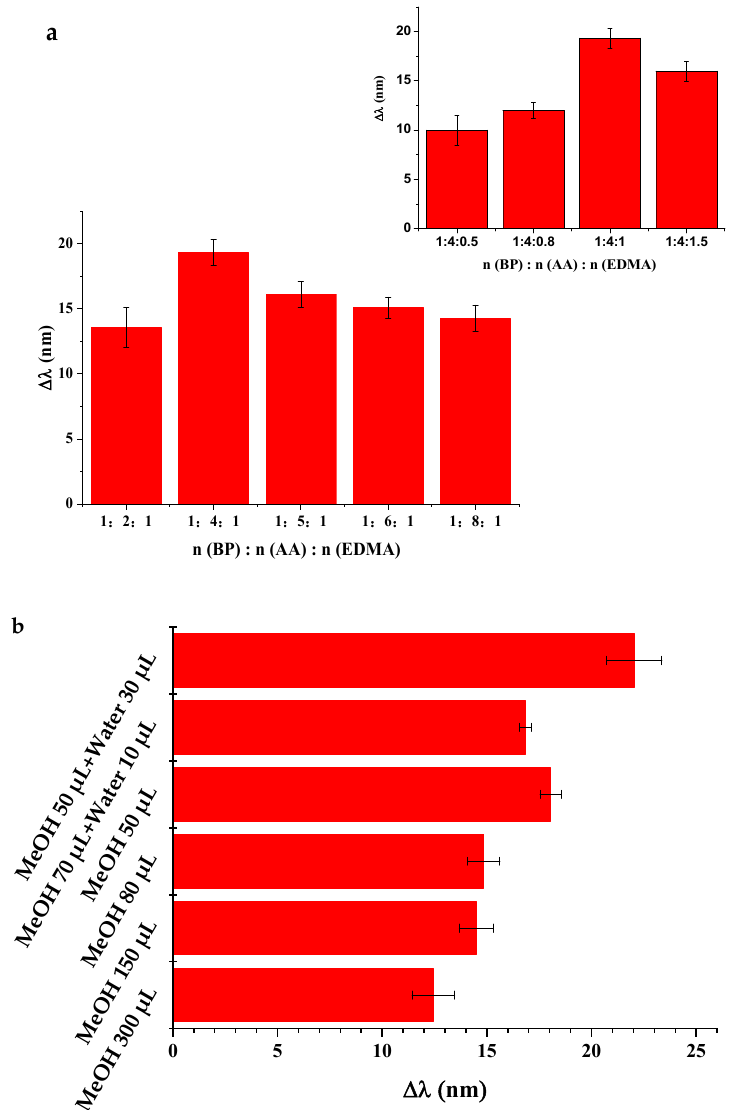
Figure 2. Effect of the molar ratio of BP, AA and EDMA in the precursor solution ( a ) and the different porogen ( b ) on the peak shift of MIPCs (The upper and lower figures in Figure 2a indicate respectively the effect of EDMA and MAA on the peak shift of MIPCs; Concentration of BP: 0.001 mol · L − 1 ).